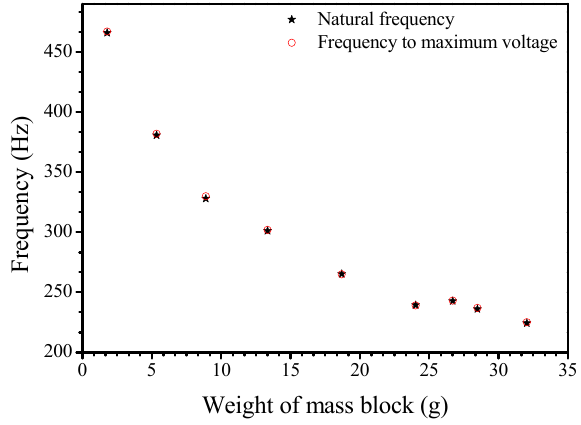
Figure 4. Weight of mass block versus natural frequency of PCP and exciting frequency at maximum voltage in simply supported beam fixation mode.